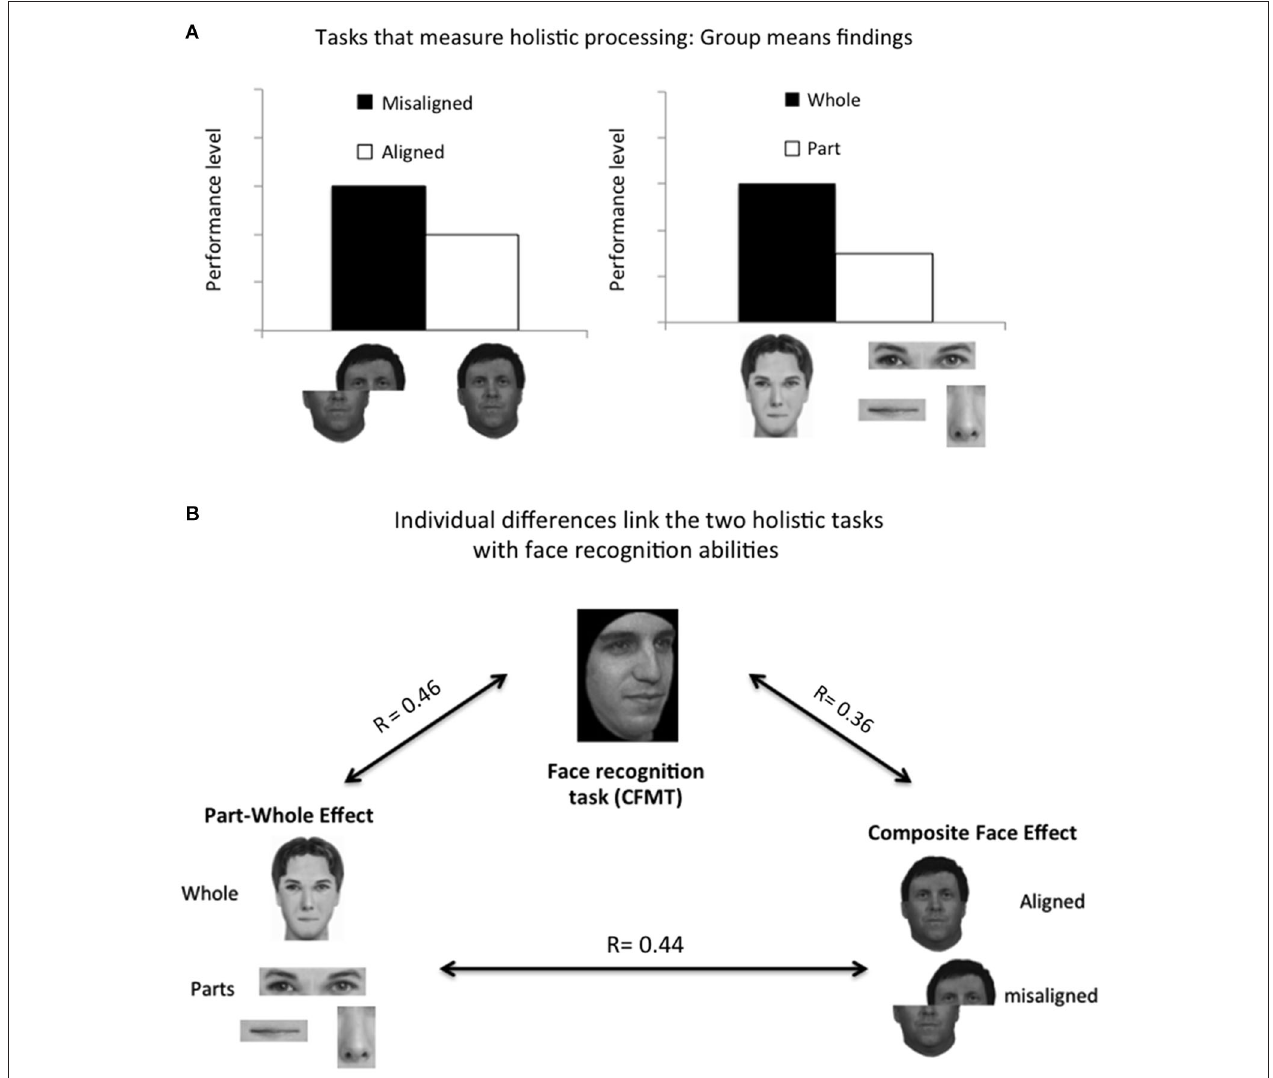
with an another face of a different identity, indicating interactions (which leads to interference) between the two face halves in the aligned condition (see also footnote 1). (B) Correlational analyses between the two measures of holistic processing and their relationship with face recognition abilities reveal moderate correlations (Degutis et al., 2013, see also footnote